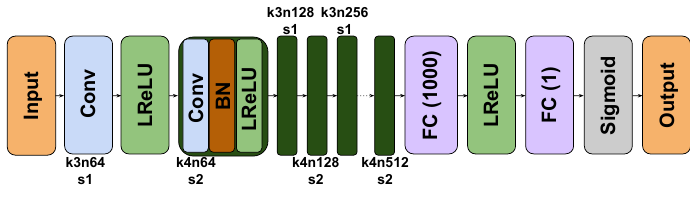
Figure 5. Architecture of the